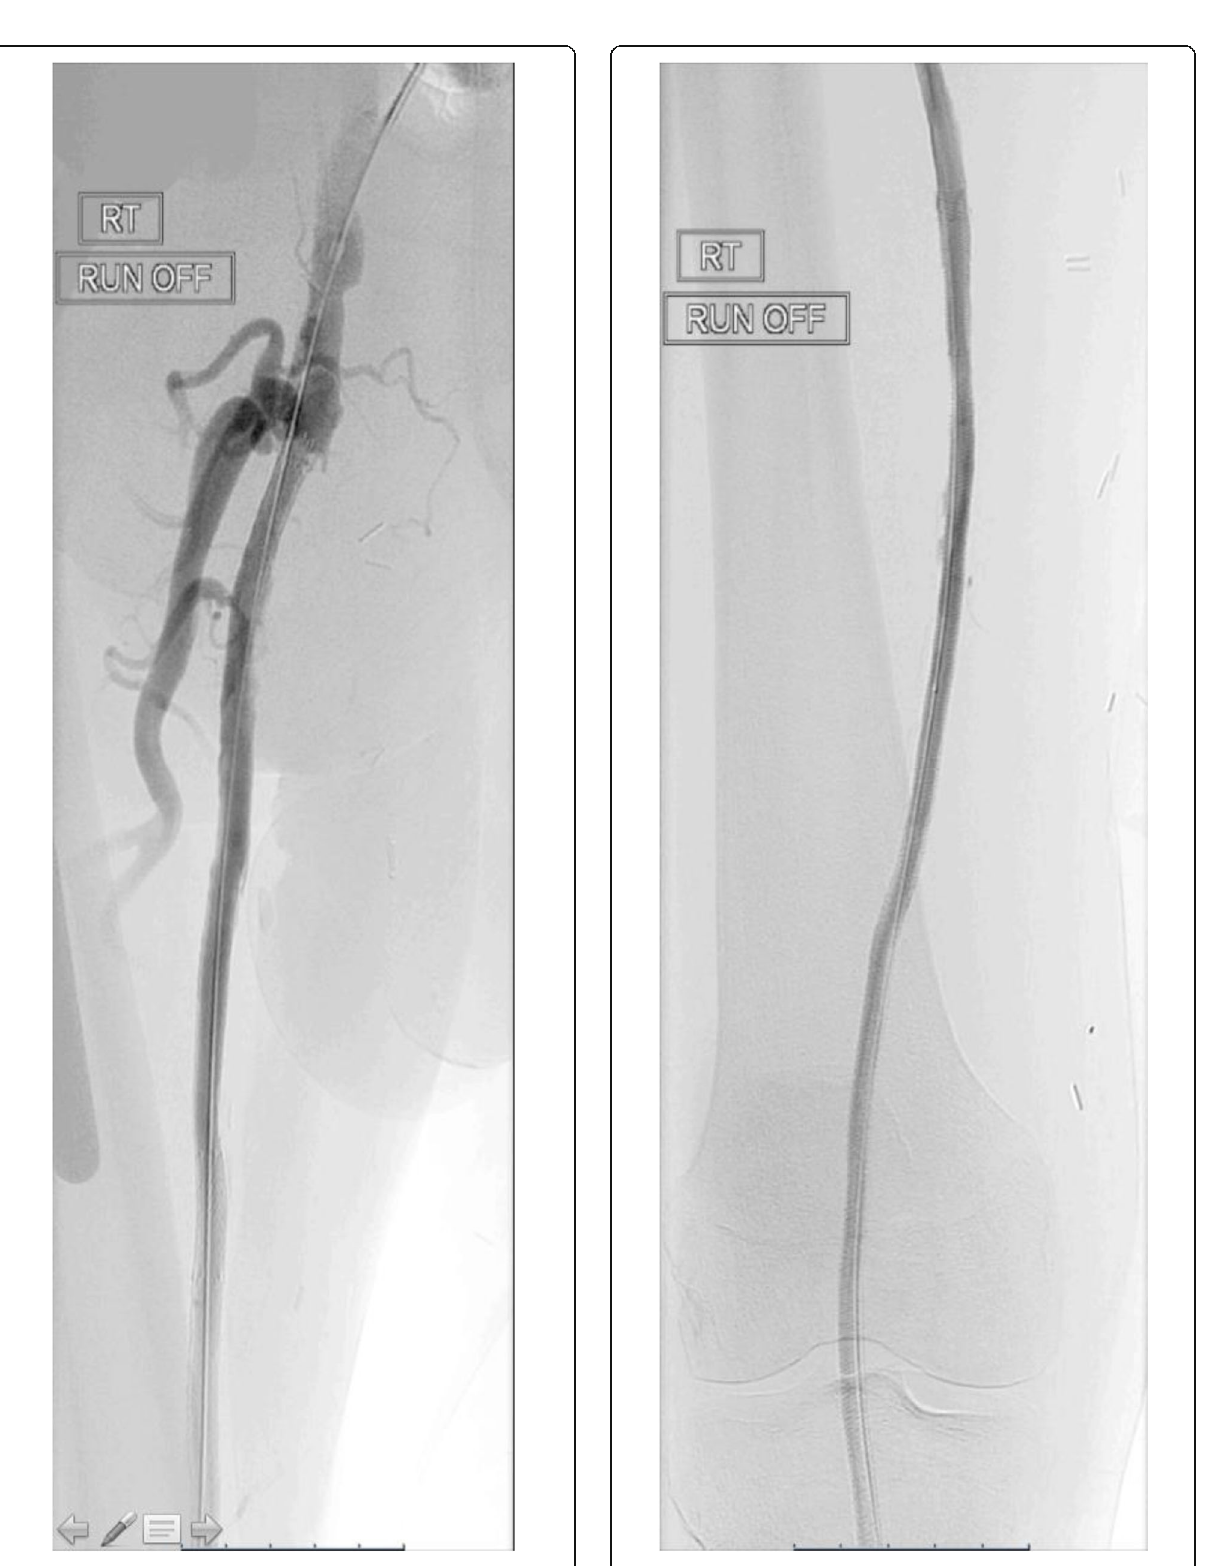
Fig. 5 SFA runoff post procedure part 1 Fig. 6 SFA runoff post procedure part